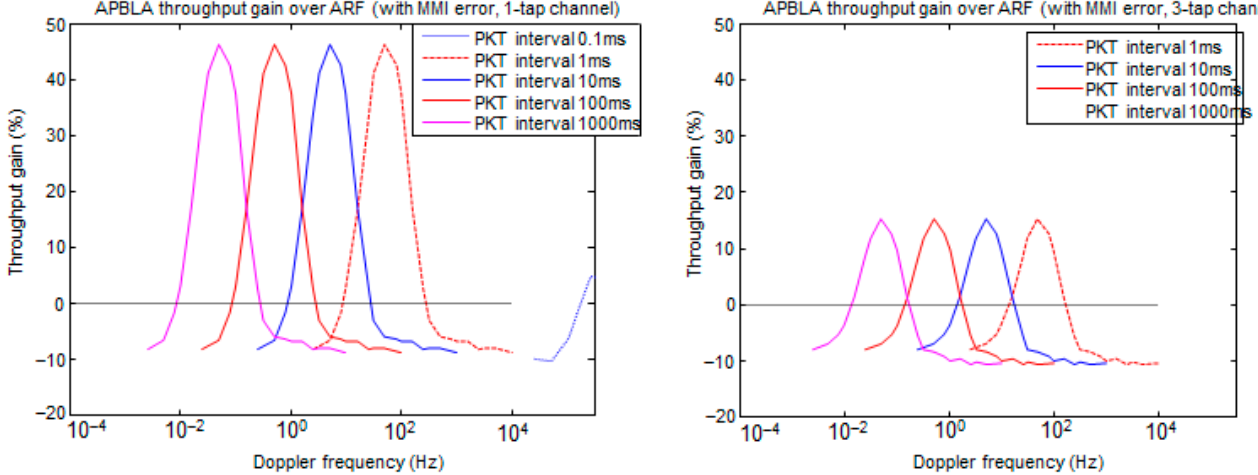
Figure 21. Throughput gain of APBLA vs. ARF as a function of Doppler frequency over various packet transmission intervals, assuming a 1-tap channel ( left ) and a 3-tap channel ( right ).